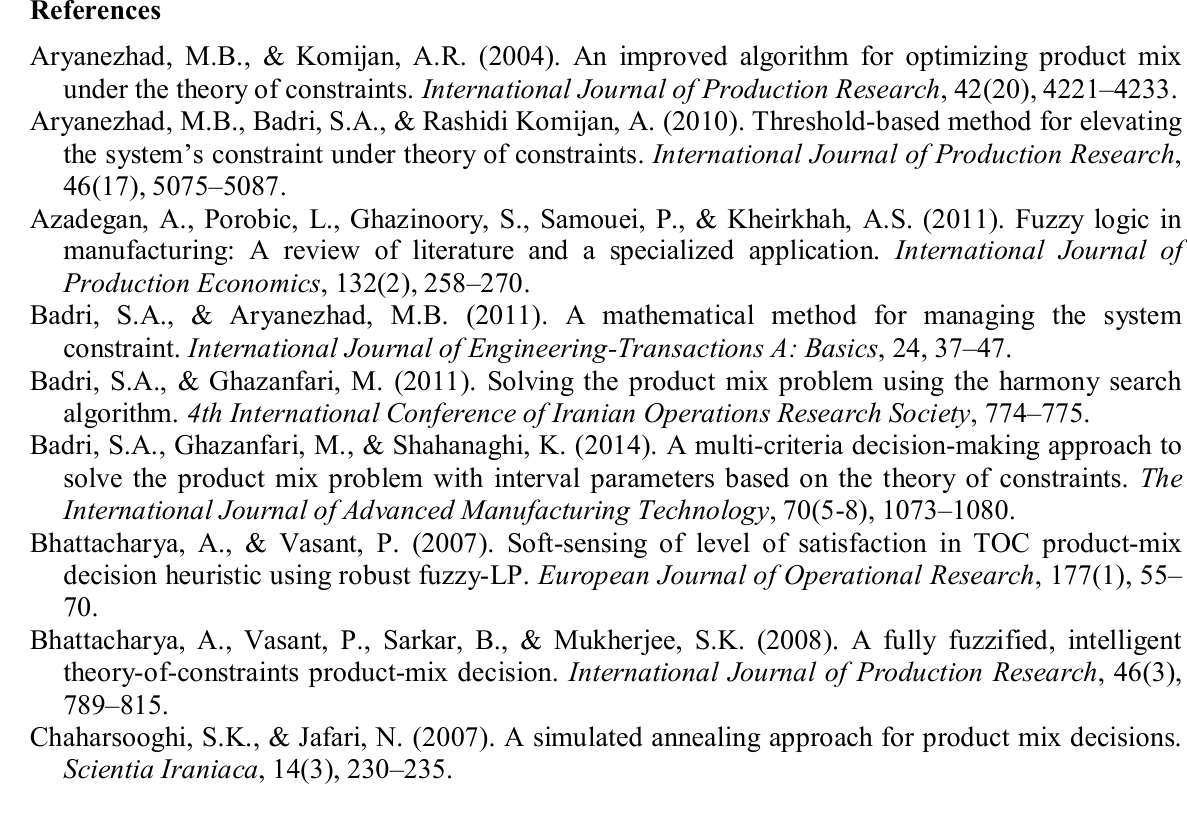
Available Prob. size capacity m×n Author (year)